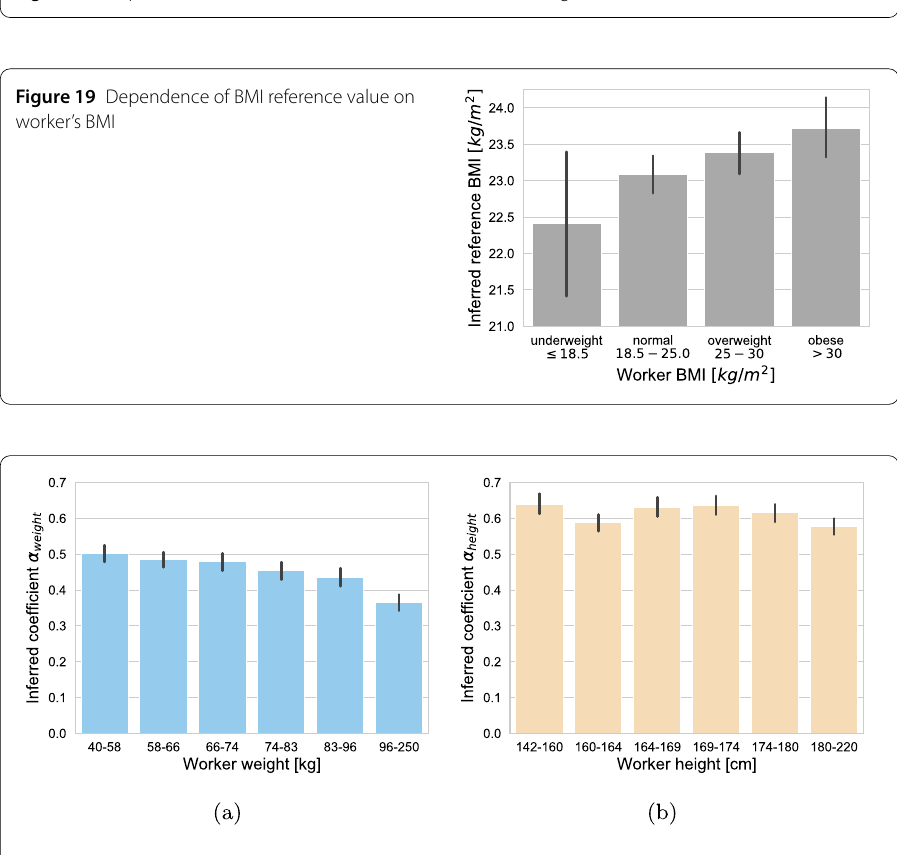
Figure 20 Dependence of weight/height contraction coefficients on worker’s weight/height